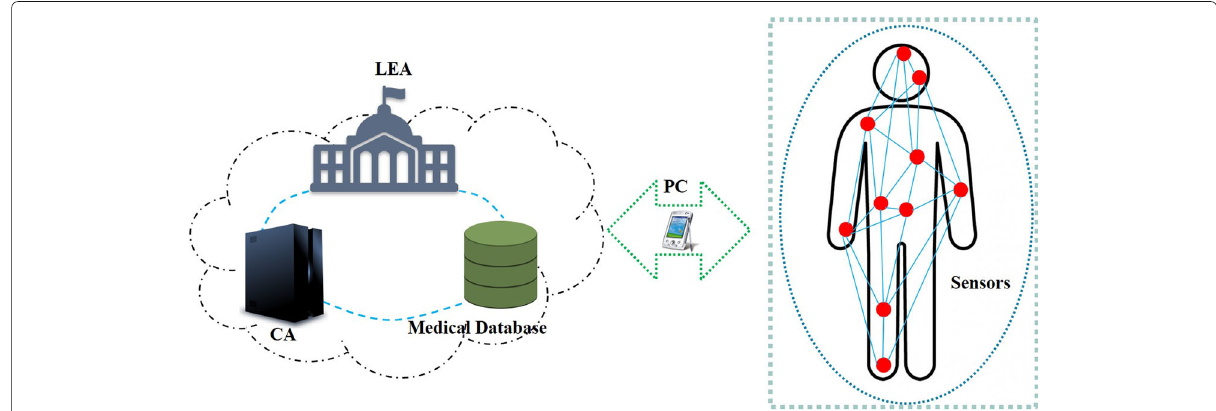
Fig. 1 Cloud-Assisted WBANs System Model